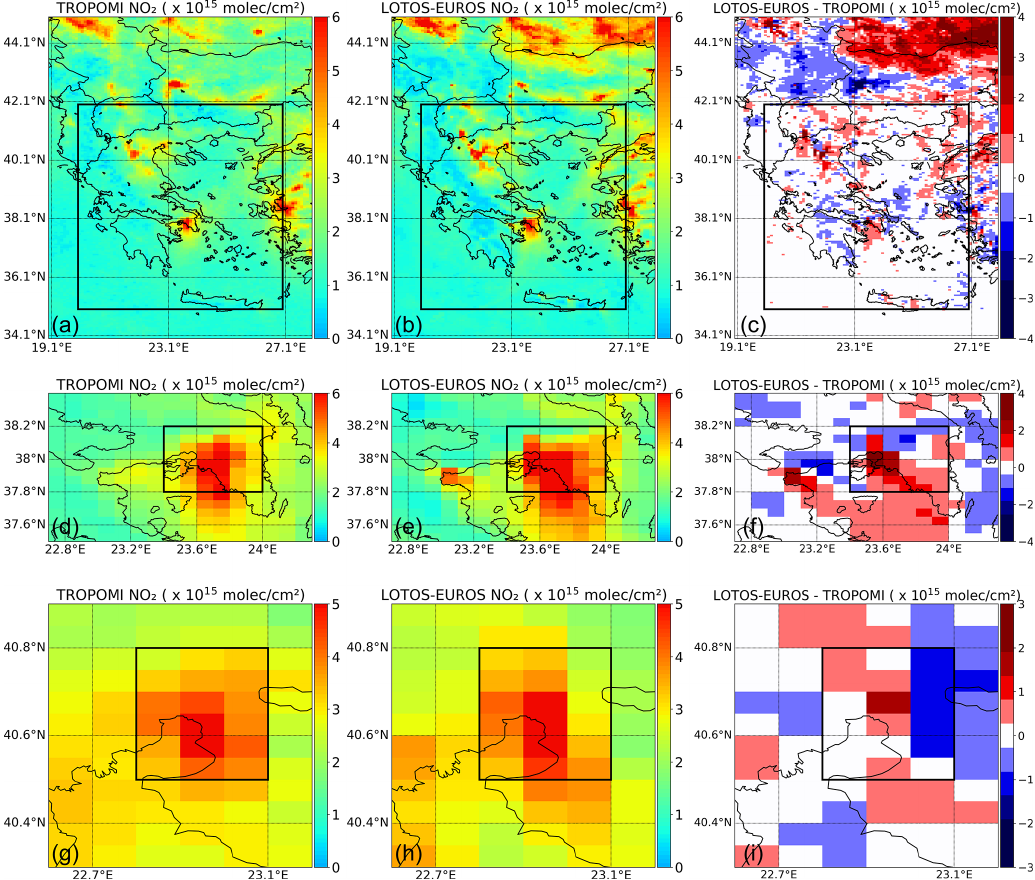
Figure 11. TROPOMI (a, d, g) and LOTOS EUROS (b, e, h) NO 2 tropospheric vertical columns over the region of Greece (a, b, c) and the sub-regions of Athens (d, e, f) and Thessaloniki (g, h, i) for December and their absolute differences (c, f, i) . Table 5. Statistics between the LOTOS-EUROS vertical NO 2 columns and the TROPOMI observations for July and December 2018. Columns and the absolute bias are expressed in 10 15 moleccm − 2 . The correlation coefficients marked with bold are statistically signifi- cant at the 95% level. TROPOMI CTM Absolute bias | Temporal